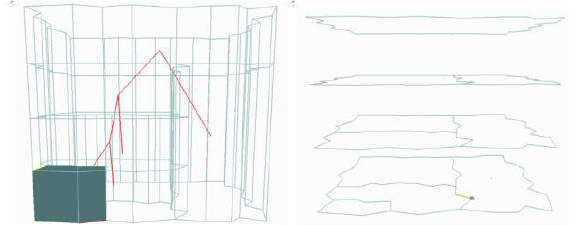
Figure 8. 2D modelling with scale as 3rd dimension and topologically connected using hierarchical graph.